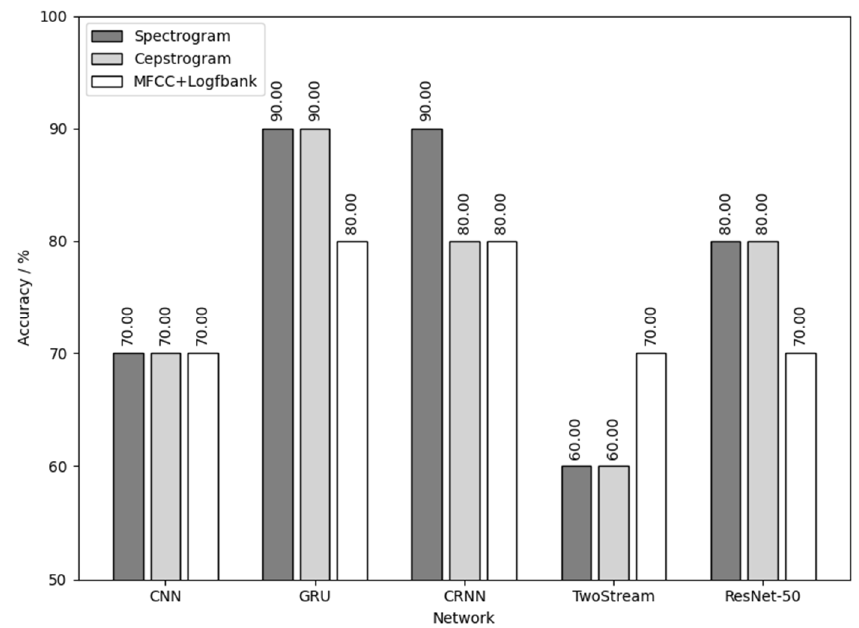
Figure 20. Native chick calls used for training and to detect the sex of native